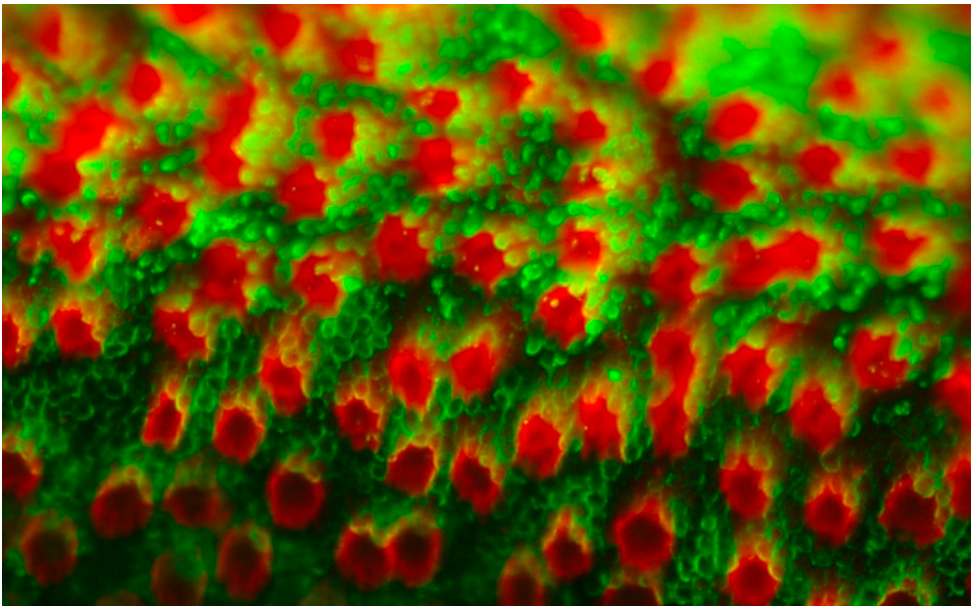
Figure 7. Insoluble interphotoreceptor matrix glycoproteins, the gene products for IMPG1 and IMPG2 are distributed in domains surrounding rod and cone photoreceptors. The relative distributions of cone matrix sheaths labeled with peanut agglutinin (red) is depicted compared to rod outer segments labeled with anti-rhodopsin (green).